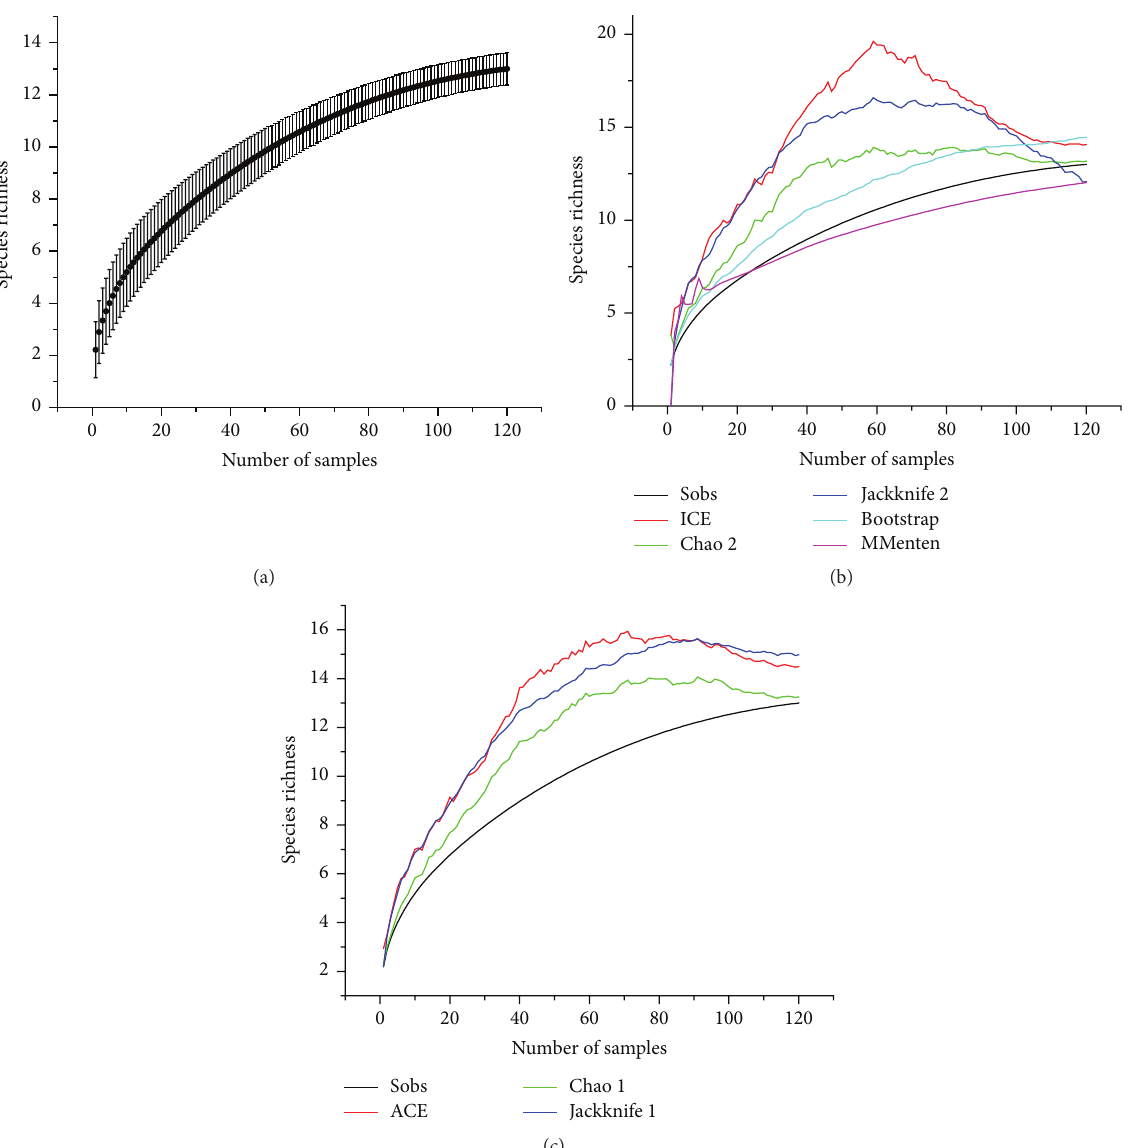
Figure 1: (a) Sample-based rarefaction curve revealed the observed species richness. (b) Showing the performance of incidence based nonparametric richness estimators for pineapple plantation. (c) Showing the performance of abundance based nonparametric richness estimators for pineapple